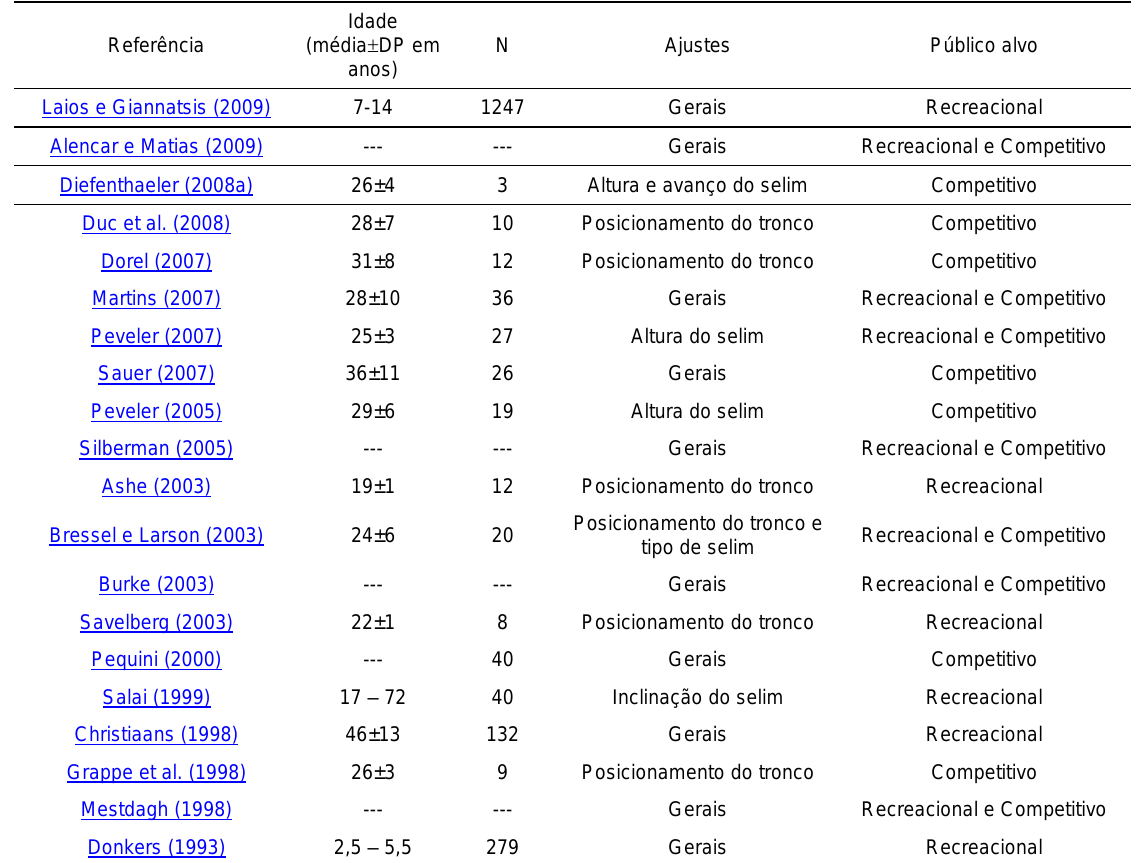
Tabela 1. Análise dos artigos selecionados de acordo com os ajustes utilizados e o nível de treinamento